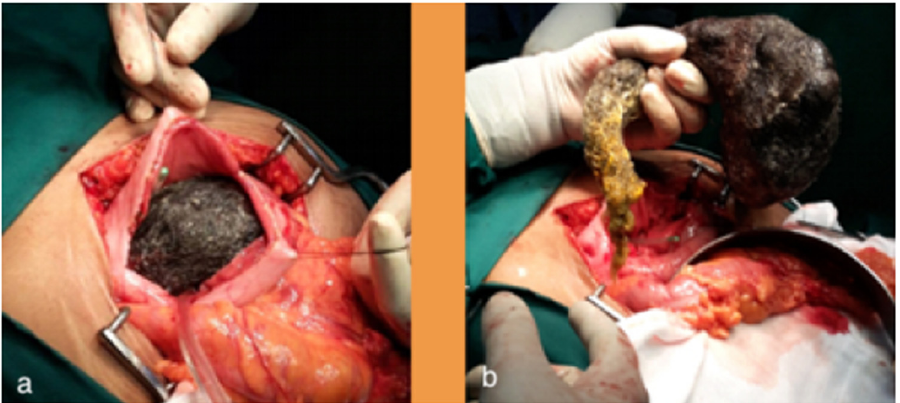
Figure 2: Panels ( a and b ) showing anterior gastrotomy and removal of the large trichobezoar extending from the stomach to the second part of